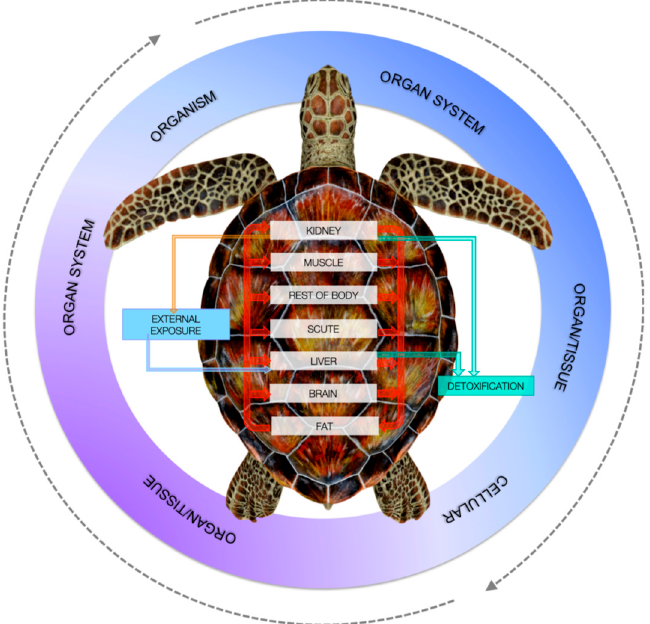
Figure 5. Different routes of exposures, elimination, and targets of PPs according to the PBK model [92]. With the permission of Elsevier.